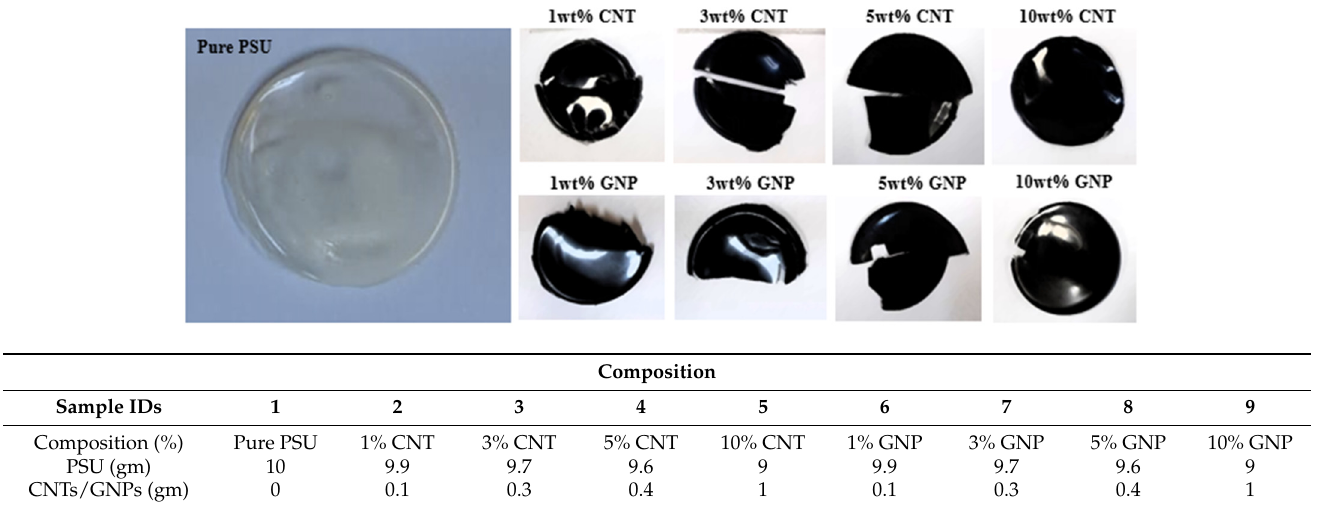
Table 1. Compositional variation of PSU and reinforcements (CNT/GNP).